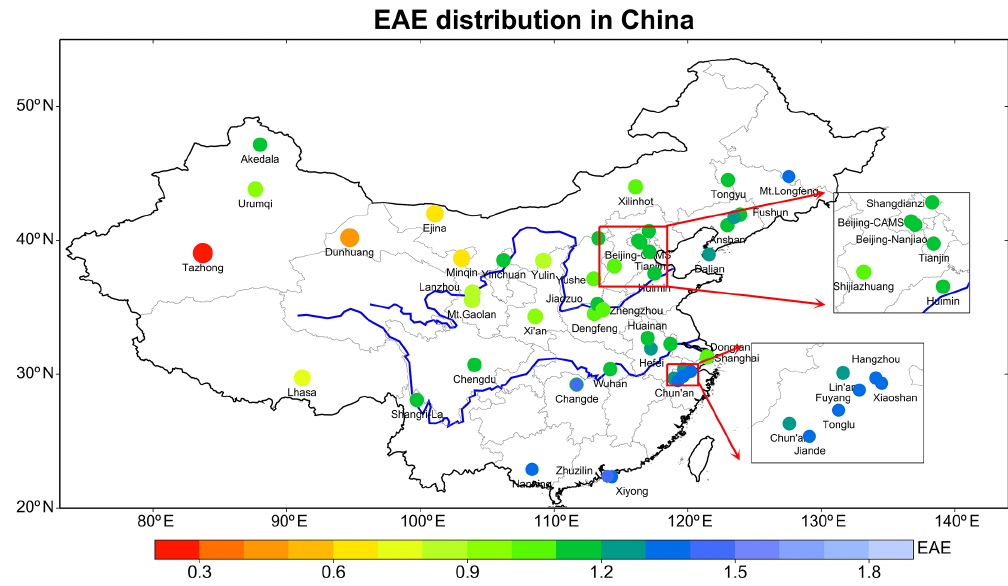
Figure 3. Annual spatial distribution of extinction Ångström exponent (AE) 440–870nm at the CARSNET